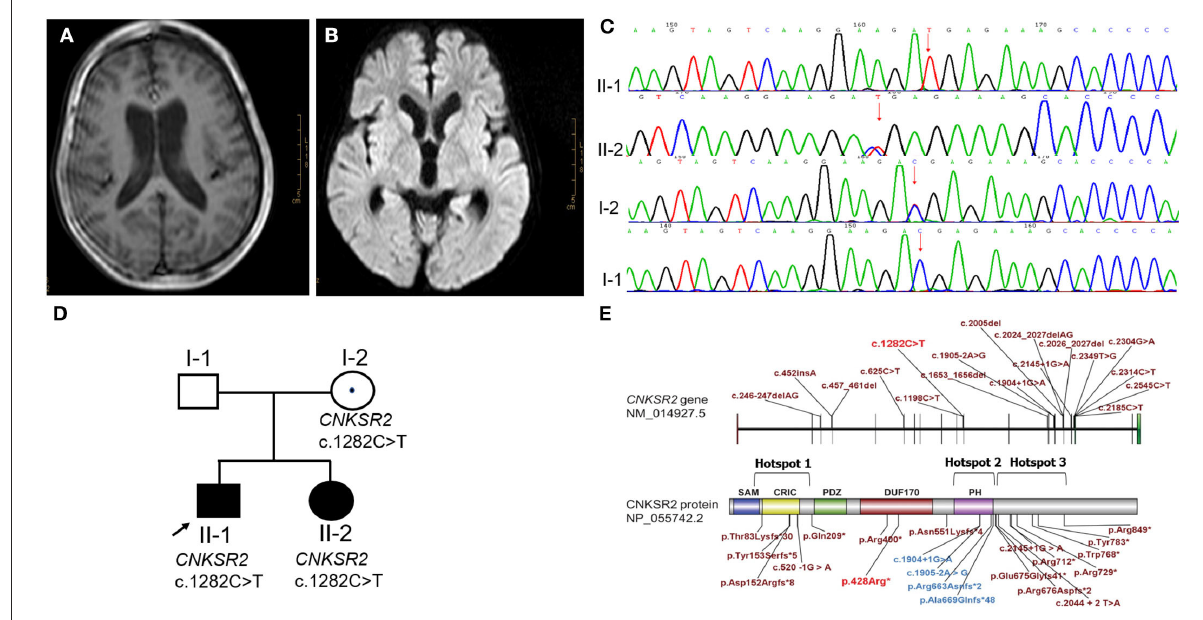
FIGURE2 Phenotype and gene variation in CNKSR2 cases. (A,B) A severe hydrocephalus, and a widened bilateral ventricle (2.5cm) and third ventricle (1cm) were scanned by MRI. (C) CNKSR2 c.1282C > T variation in CNKSR2 family was confirmed by Sanger sequencing. (D) Family pedigree of